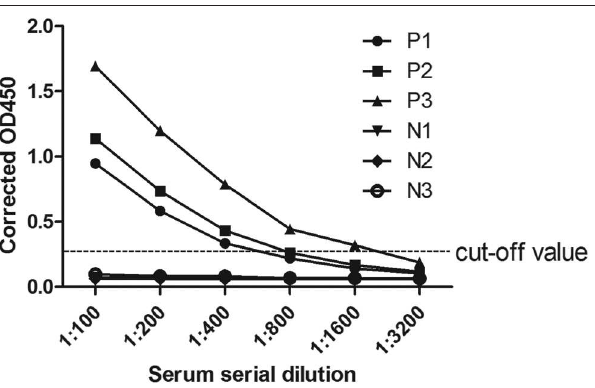
FIGURE 4 | Anti-CanineCV antibody titers in positive and negative canine serum samples. Positive and negative canine serum samples were prepared in dilutions of 1:100, 1:200, 1:400, 1:800, 1:1,600, and 1:3,200 used in an ELISA assay. The cutoff was determined by counting the mean OD value of the ELISA negative samples plus 3 standard deviation